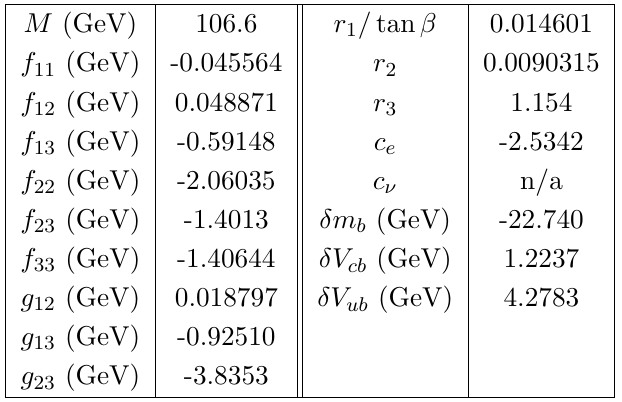
Table 5 . Fit values for the input parameters at the GUT scale for a sample (cid:12)t with type-II seesaw (taken from [53]).